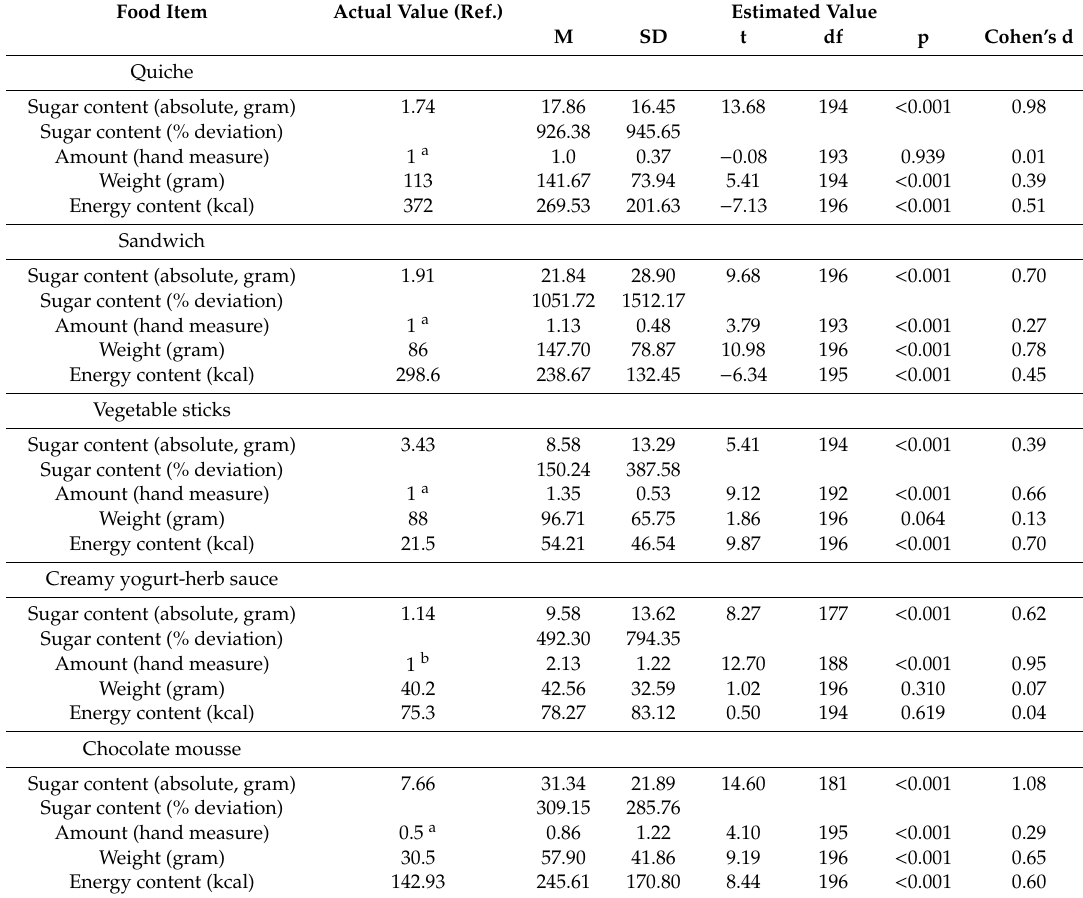
Table 1. Estimation accuracy by food item and estimation